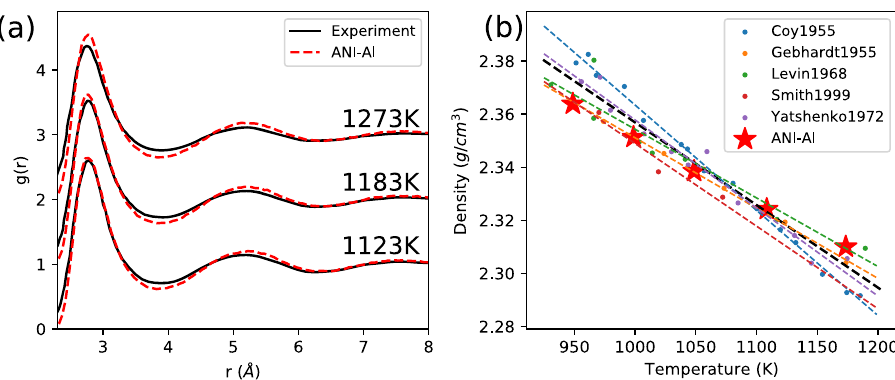
Fig. 4 Molecular dynamics simulation in melt using the ANI-Al potential. a Radial distribution function at temperatures 1123, 1183, and 1273 K compared to experiment 61 (black line). b Density predictions as a function of temperature. The dashed black line is a linear fi t to all fi ve sources of experimental